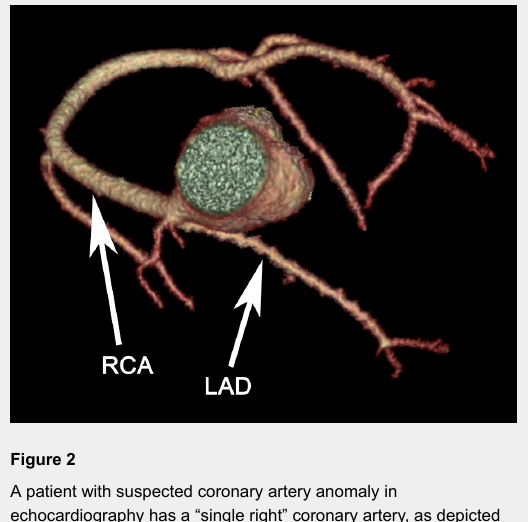
A patient with suspected coronary artery anomaly in echocardiography has a “single right” coronary artery, as depicted by CCTA. CCTA = coronary computed tomography angiography; LAD = left anterior descending artery; RCA = right coronary artery